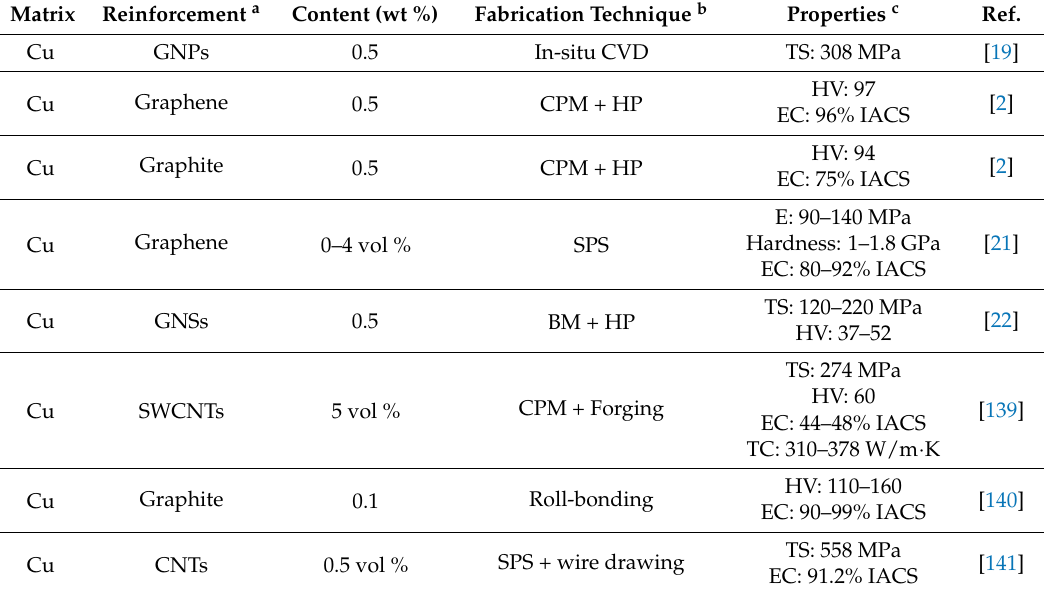
Table 3. A summary of recent research on CuMCs reinforced by carbon allotropes. Matrix Fabrication Technique b Properties c